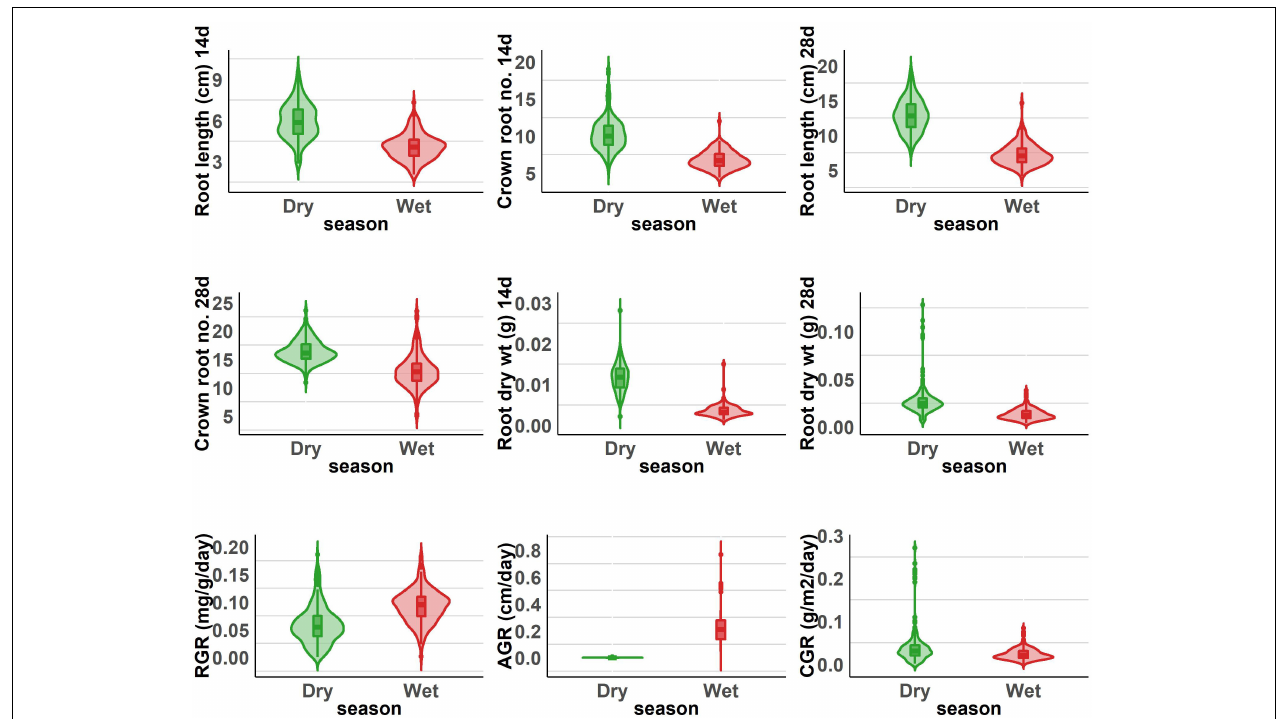
FIGURE 1 | Root length, dry weight, crown root number, and root vigor index of dry and wet seasons under DSR conditions.